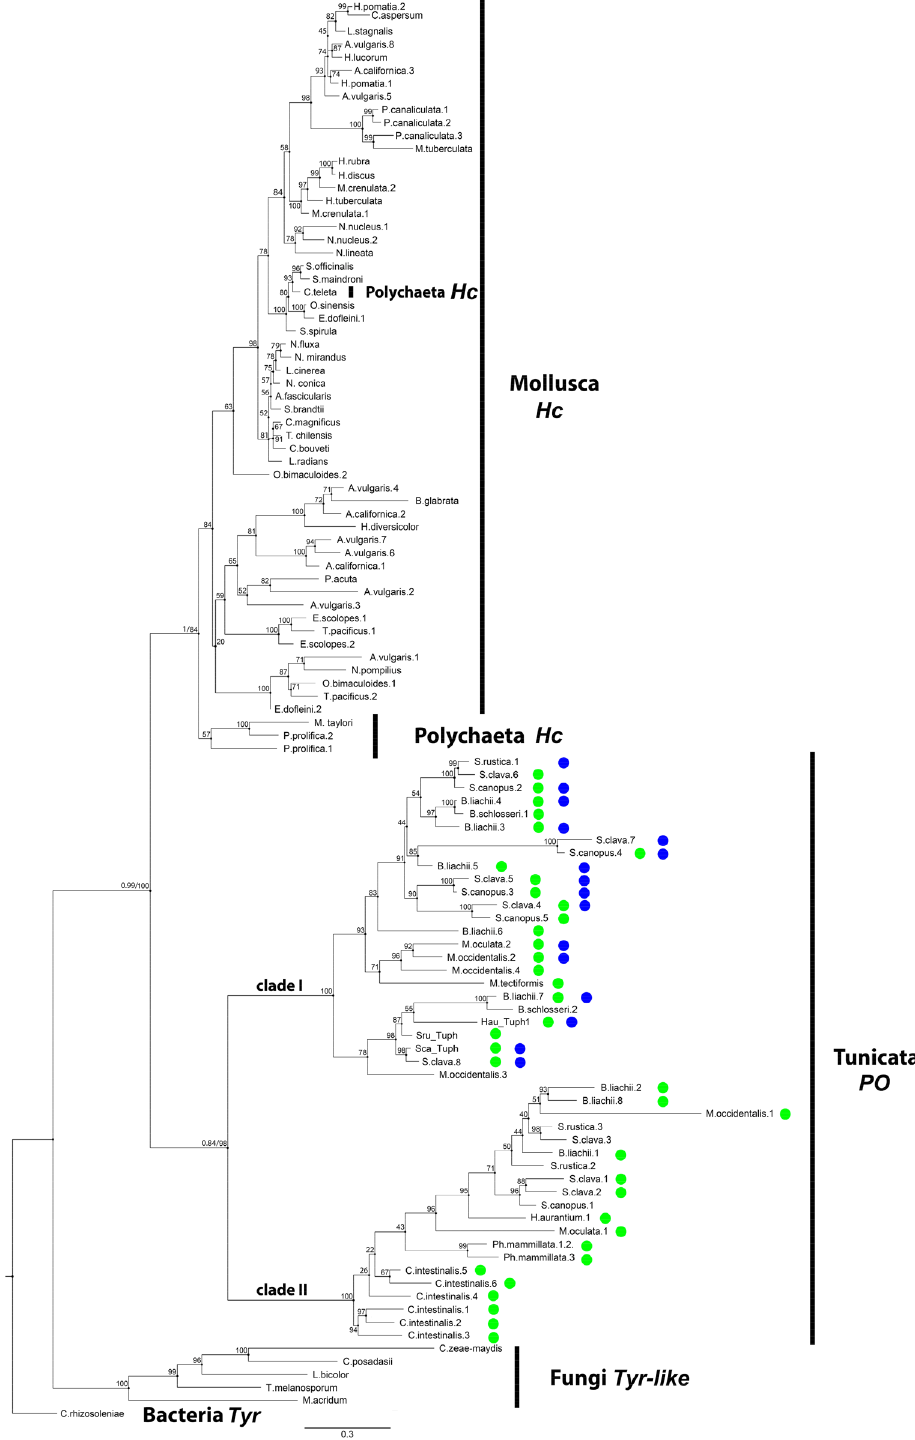
Figure 6. Phylogenetic analysis of tyrosinase domains of Tuphoxin homologues. A representative phylogenetic tree based on maximum likelihood (ML) inference. Hc haemocyanin, PO phenol oxidase, Tyr tyrosinase. Presence of cupedoxin-like sequence (blue cycles) and thrombospondin first type repeat-TSP1 domain (green cycles) is indicated for Tunicata POs. Statistical support is indicated at the nodes; for main branches first number is Bayesian Inference (BI) posterior probabilities; second number is ML bootstrap support. For all other branches only bootstrap support is indicated. Accession numbers of the sequences used in this tree can be found in Supplementary Table